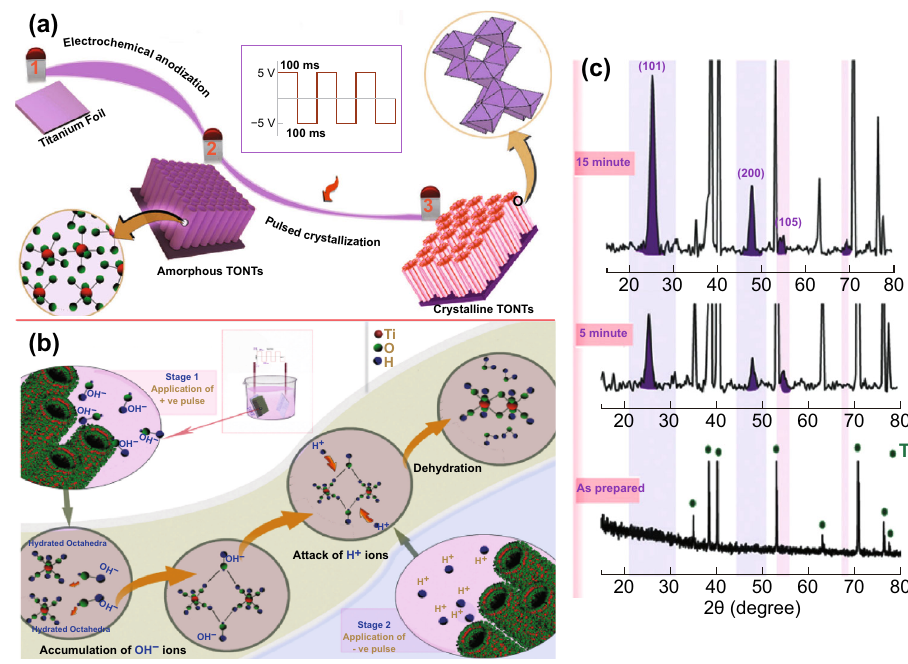
Fig. 8 a Schematic illustration of the crystallization process at room temperature: first step: electrochemical anodization; second step: pulsed crystallization. b The mechanism of the superfast room temperature crystallization of TNTs. c XRD patterns of the as-anodized and pulsed- crystallized TNTs [82]. Copyright (cid:2) 2017 The Royal Society of Chemistry